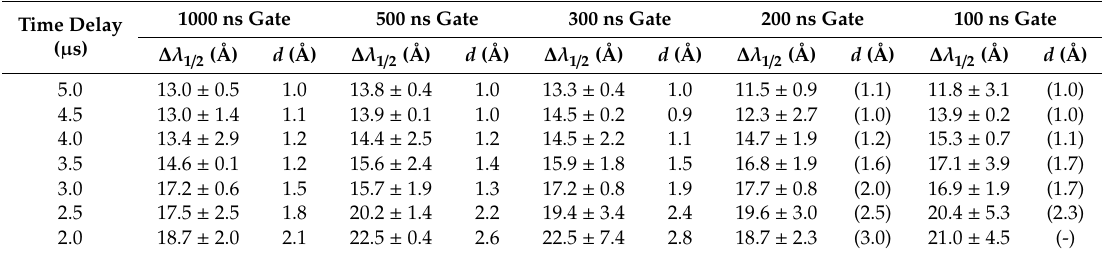
Table 1. Experimental Stark broadening ( ∆ λ 1 / 2 (Å)) and red Stark shift ( d (Å)) of the H α -line obtained in the LSP experiments of this